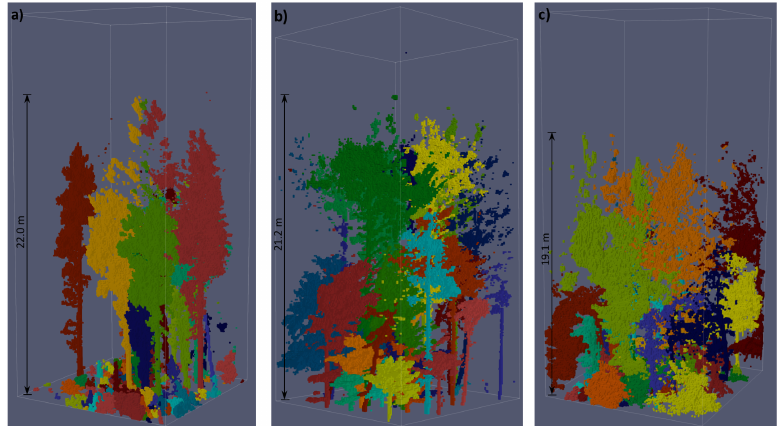
Figure 5. Final clustering results of the quadrants Q1 on plots one, four and five. Plot one in ( a ) is characterized by many small trees close to the ground and grouped trees in the upper layer. Plot four in ( b ) has an interlocking crown structure in the mid and upper layers with clearly visible stems below. Plot five in ( c ) has trees in all layers, is densely structured and has crowns of irregular shape.